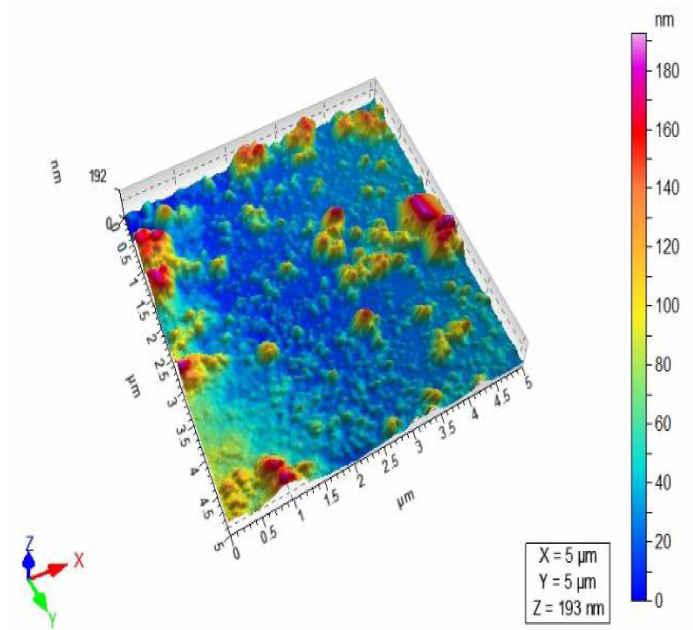
Figure 4. AFM 3D image of C. roseus nano particles by using a scale of 60 nm. Table 2. AFM images of C. roseus nanoparticle by 60 scale. Serial